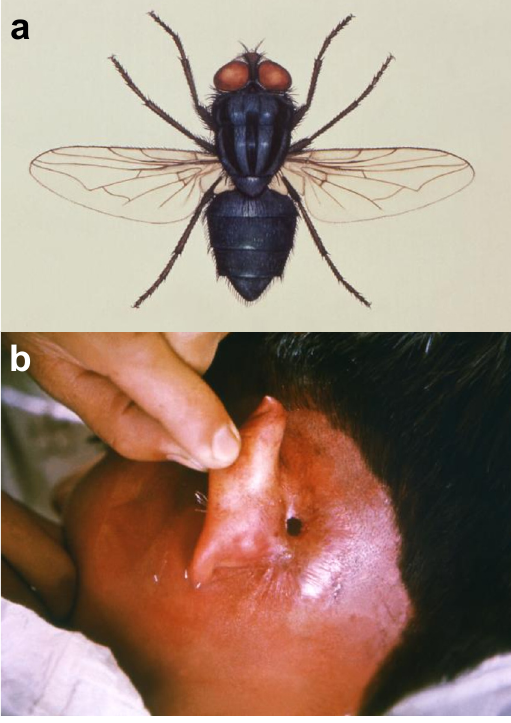
Figure 1. The New World screwworm, Cochliomyia hominivorax (Coquerel) (Diptera: Calliphoridae) ( a ); C. hominivorax can cause severe myases on humans, including head soft tissues burrowing post-oviposition inside the ear canal ( b ) (image credits, a: CDC-PHIL; b: Dr. K. Dewitt, CDC-PHIL).